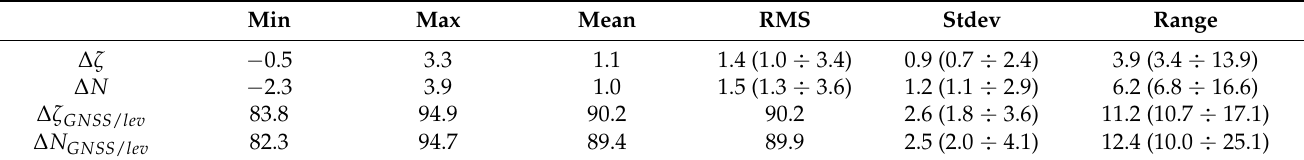
Table 2. Basic statistics of the differences ∆ ζ = ζ GGI − ζ m , ∆ N = N GGI − N m , as well as ∆ ζ GNSS / lev = ζ GGI − ζ GNSS / lev and ∆ N GNSS / lev = N GGI − N GNSS / lev , based on the GSVS17 profile points (in centimeters). In brackets are ranges of corresponding values obtained for methods participating in the Colorado geoid experiment (based on